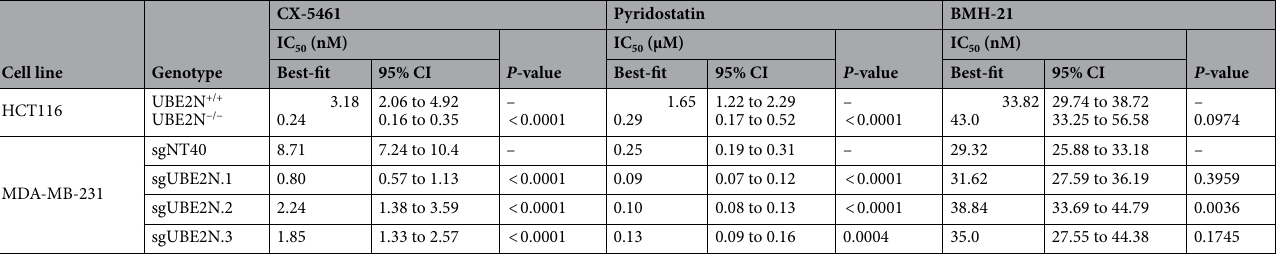
Table 3. Mean IC 50 values, 95% confidence intervals (CI) and P -values for CX-5461, Pyridostatin and BMH- 21 dose response upon UBE2N gene